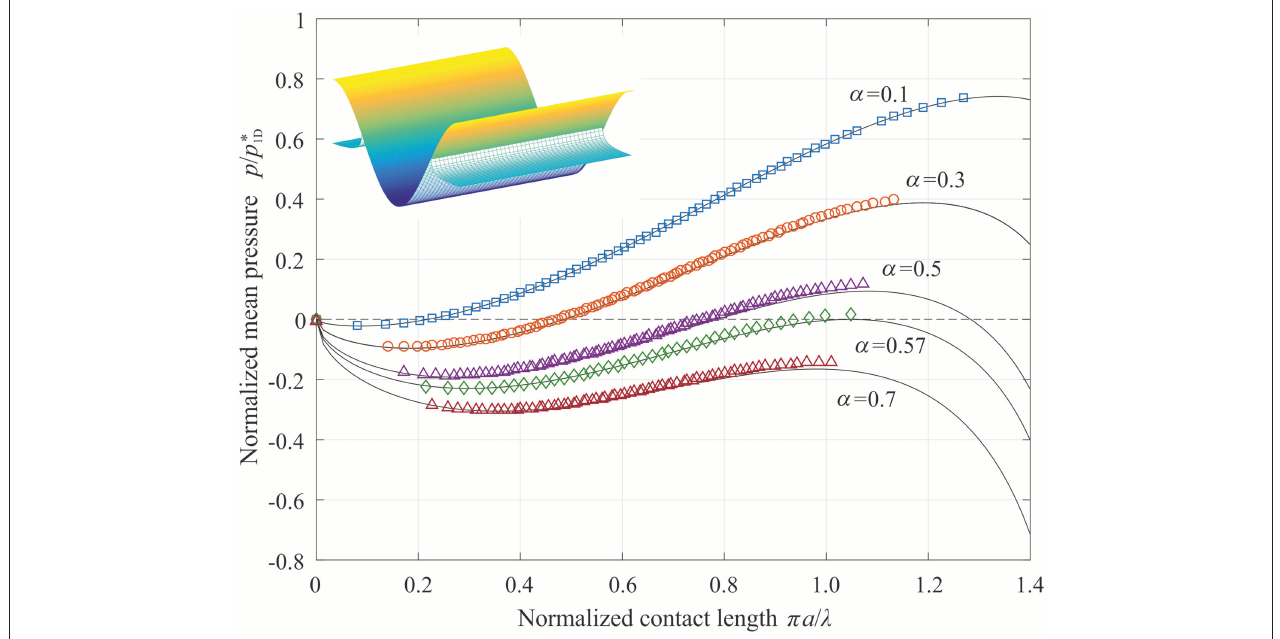
FIGURE 1 | Dependence of the mean pressure on the contact half-width in “one-dimensional” adhesive contact. Solid lines show analytical solution and symbols present results of numerical simulation with BEM.